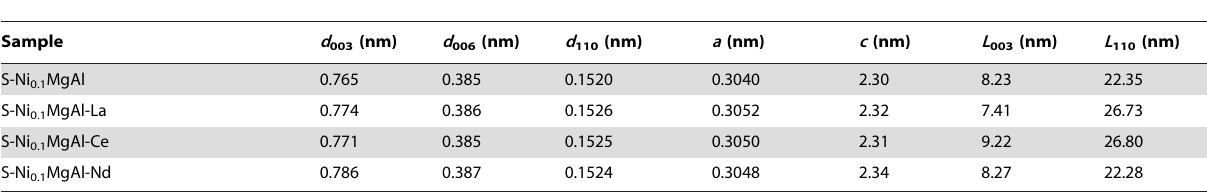
Table 1. XRD data and structural parameters of all LDHs samples.